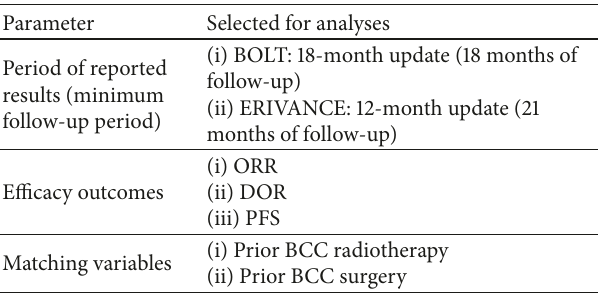
Table 3: Parameters selected for